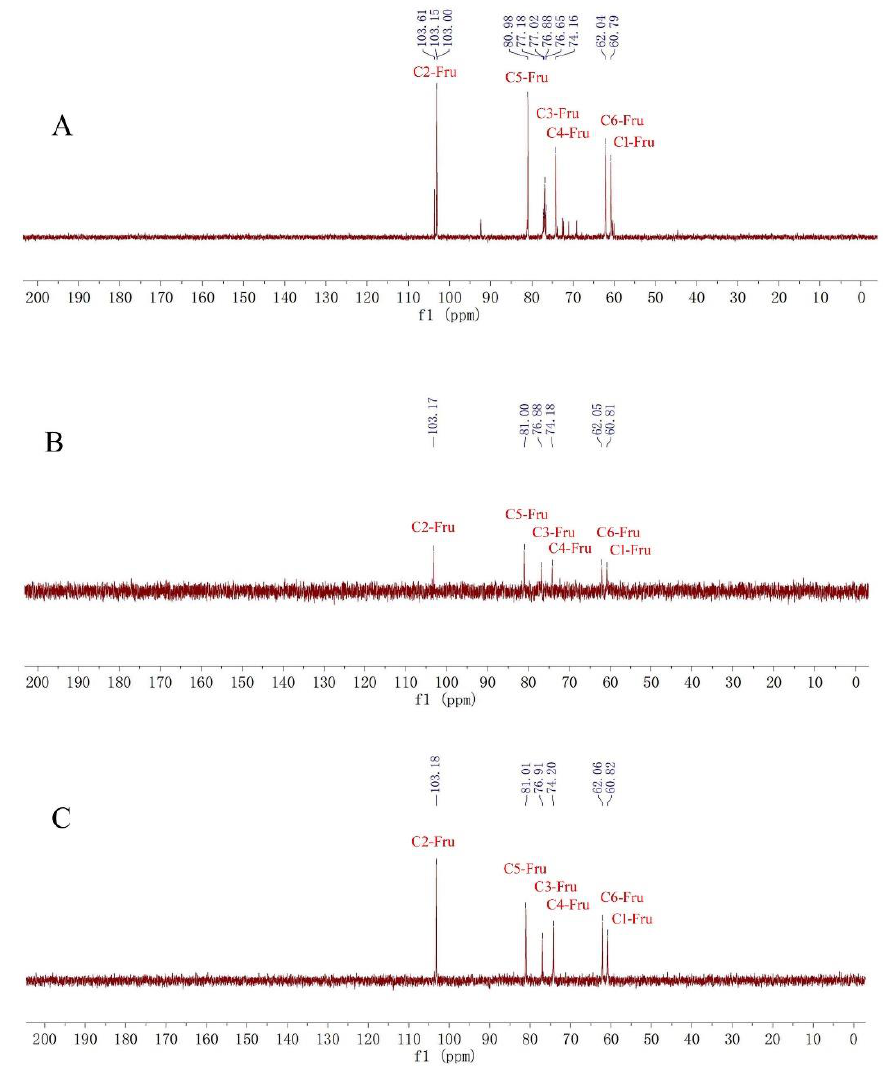
Figure 3. 13 C spectra of fructans 1 ( A ), 2 ( B ) and 3 ( C ).